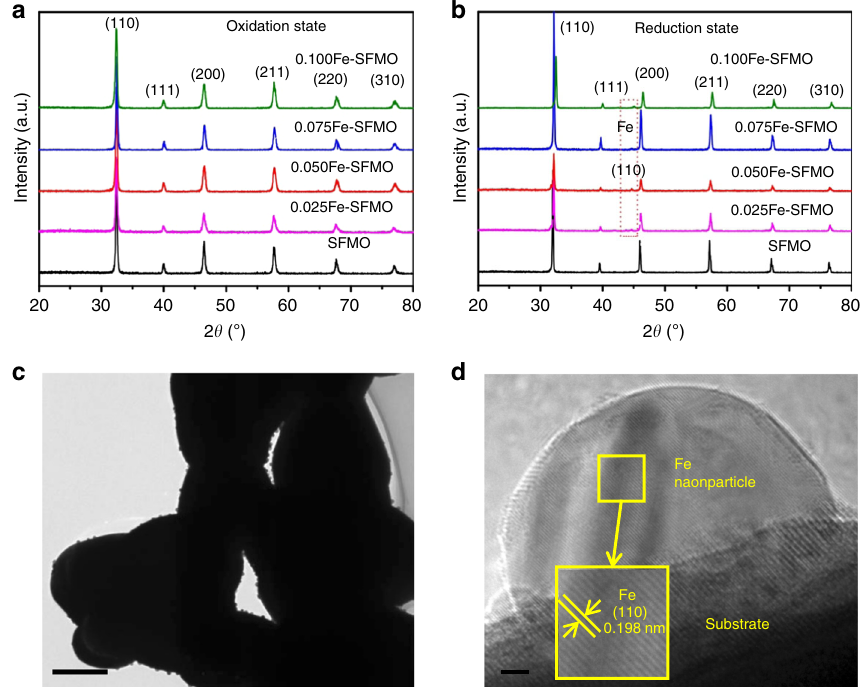
Fig. 2 X-ray diffraction patterns and micrographs. a X-ray diffraction (XRD) patterns of oxidized samples. b XRD patterns of reduced samples. c High- resolution transmission electron microscopy (HRTEM) view of iron nanoparticles and the scale bar is 500 nm. d Enlarged view of iron nanoparticle anchored on the SFMO surface after reduction and the scale bar is 2